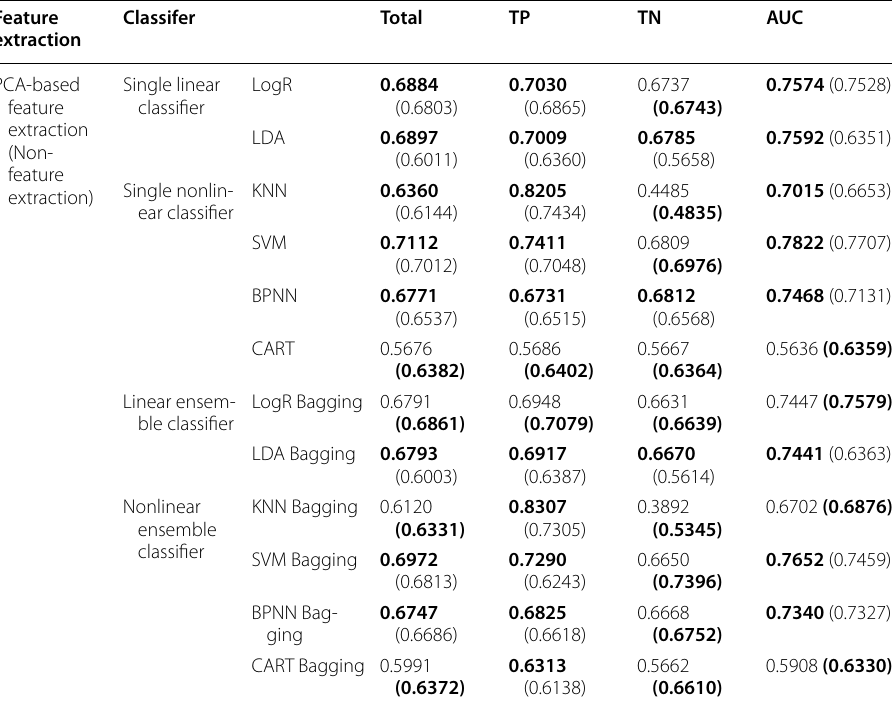
Table 1 Results of different classifiers with/without PCA in Kaggle dataset when 100 < feature dimensions < sample